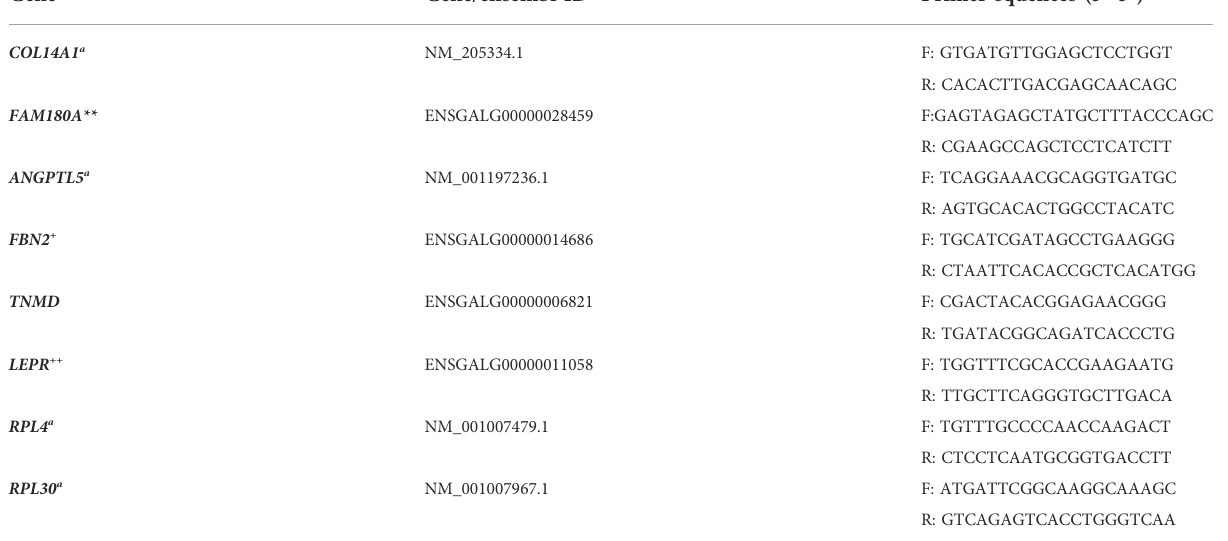
TABLE 1 Gene identi fi cation and primers used in the qPCR